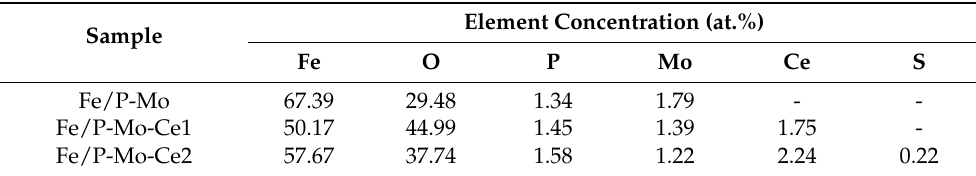
Table 1. Composition of the conversion coatings (energy dispersive X-ray (EDX) results for samples prepared for SEM